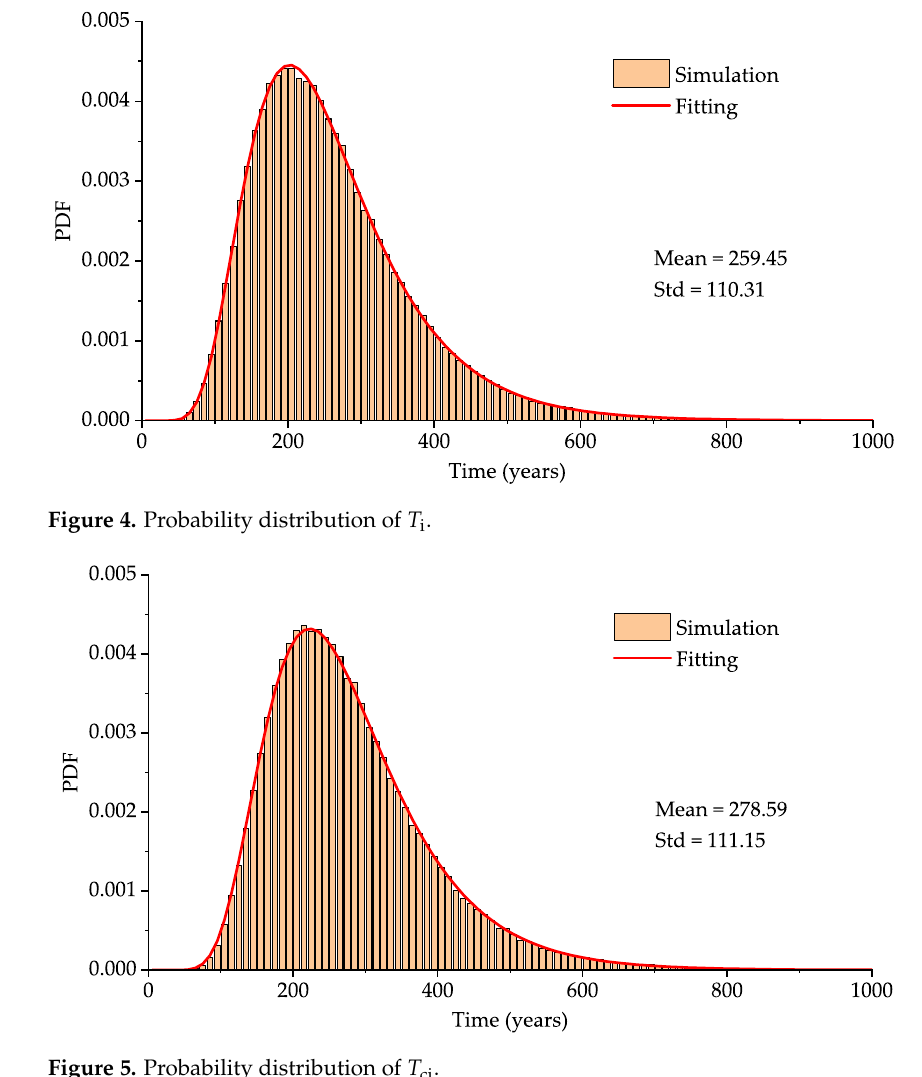
Figure 5. Probability distribution of T ci